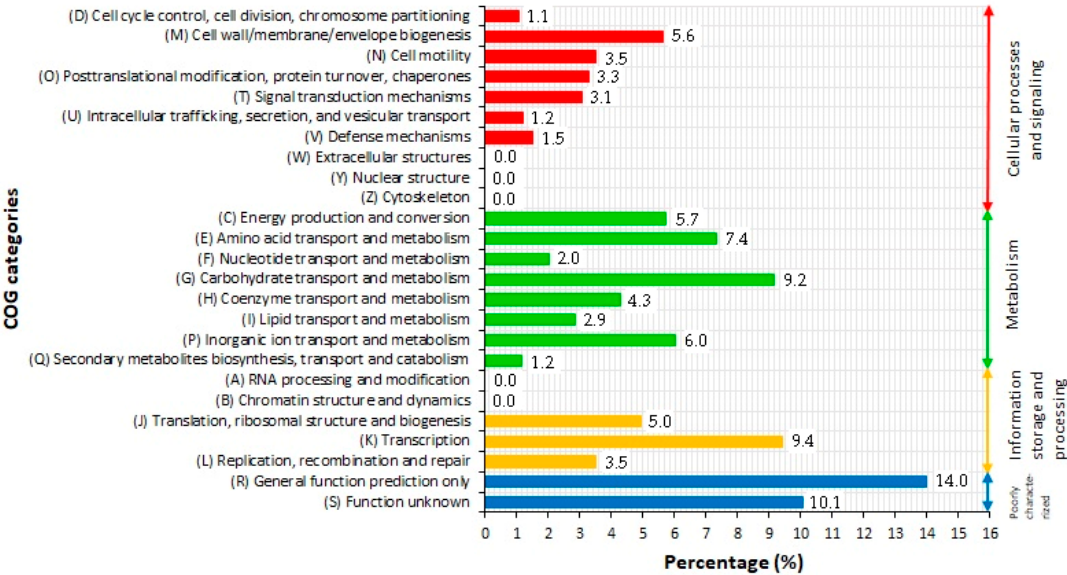
Figure 3. Classification of COG functional annotation of Enterobacter sp. LU1. Colored bars indicate percentage of genes assigned to each COG category.